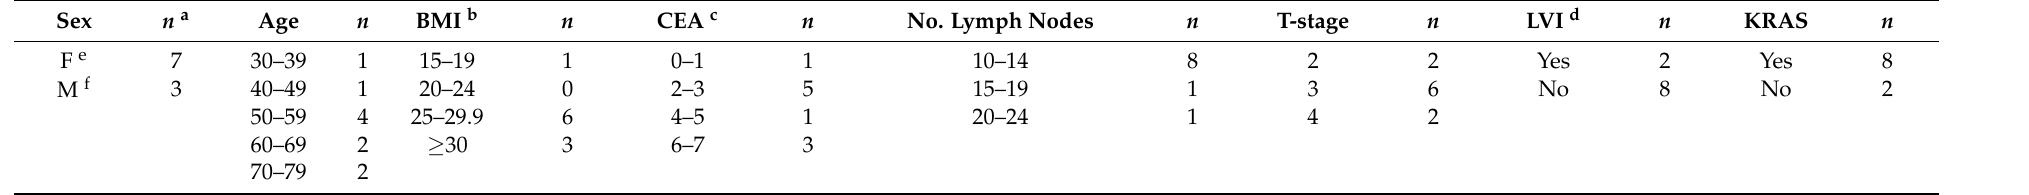
Table 1. Colorectal cancer (CRC) patient’s